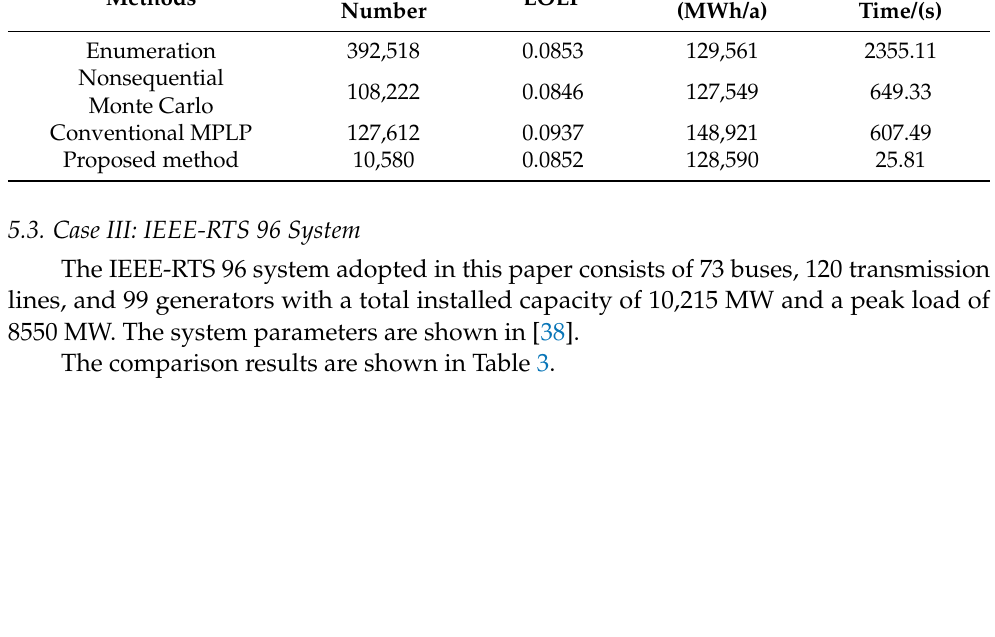
Figure 4. The single-line diagram of IEEE-RTS 79 system. Table 2. Reliability assessment results of the IEEE-RTS 79 system.